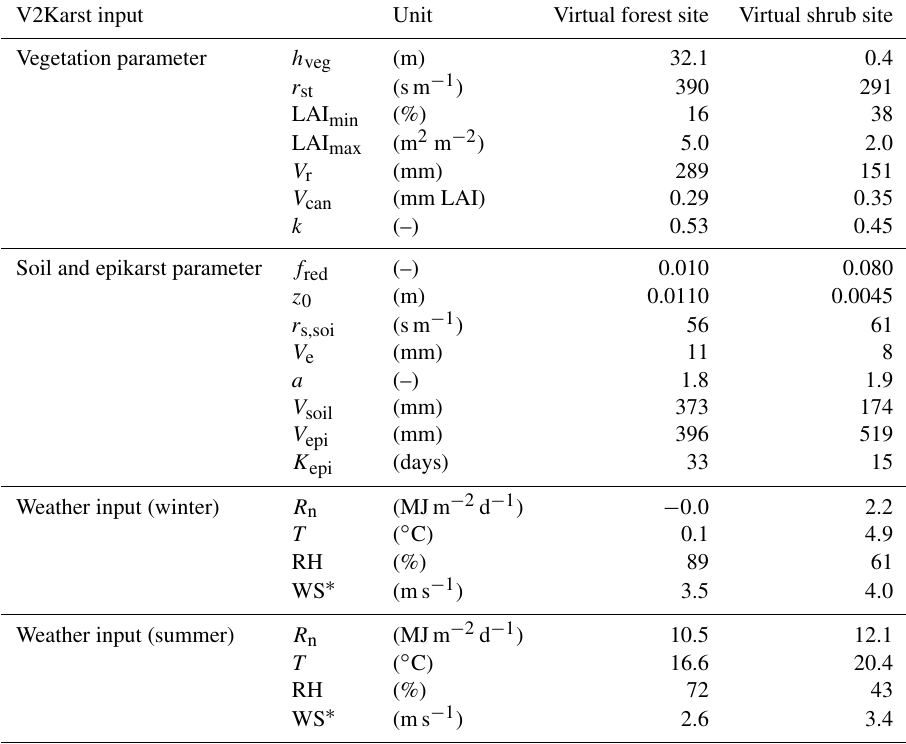
Table 4. Values of V2Karst parameters and weather variables used in the virtual experiments. Values for the virtual forest site and the virtual shrub site are based on the characteristics of the German FLUXNET site and Spanish FLUXNET site, respectively. Values of the model parameters (parameters are defined in Table 1) correspond to behavioural parameterisations obtained when calibrating the model at FLUXNET sites. Values of the weather variables ( R n – net radiation, T – temperature, RH – relative humidity and WS – wind speed) correspond to the average values calculated at FLUXNET sites.